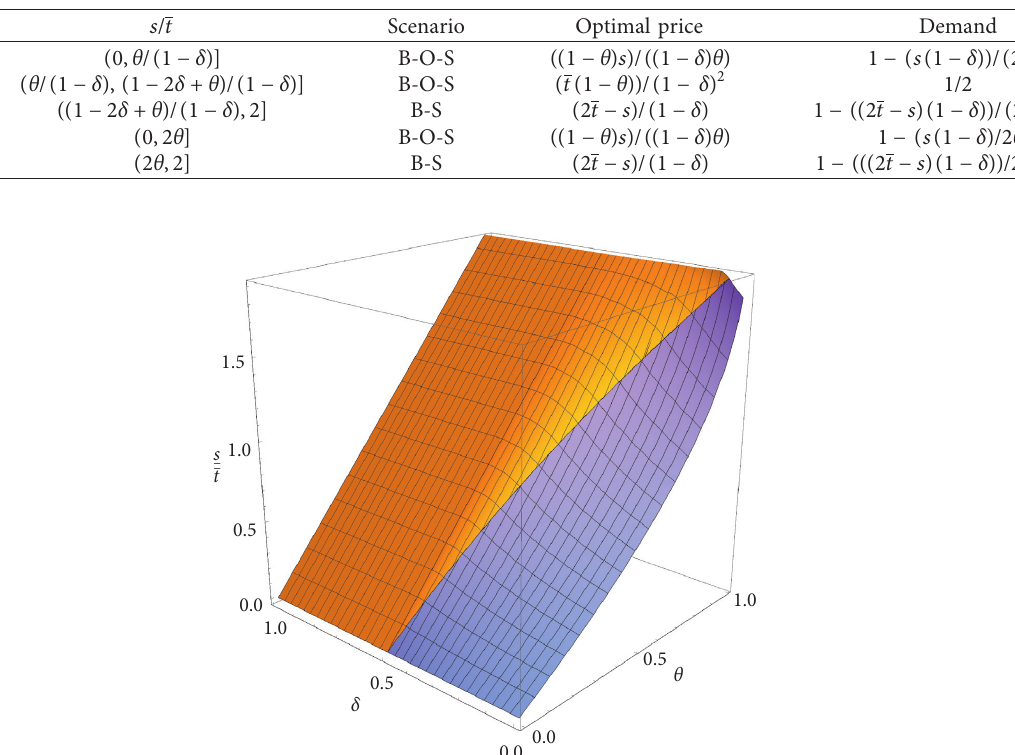
Table 2: The optimal scenario and the corresponding conditions.